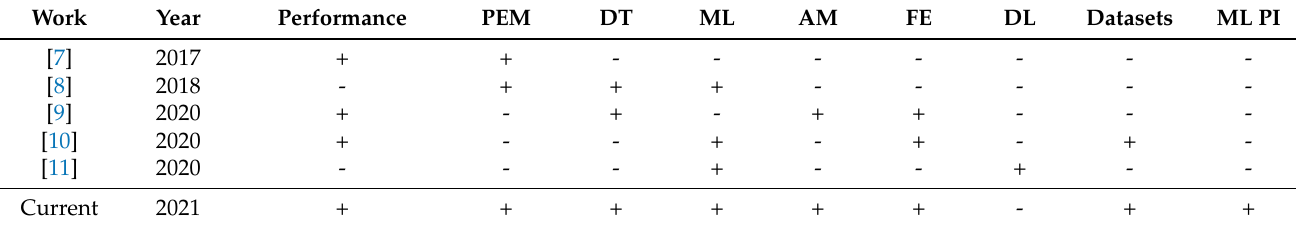
Table 2. Important topics addressed by the related works. PEM: performance evaluation metrics, DT: detection techniques, ML: machine learning, AM: analysis methods, FE: features and feature extraction, DL: deep learning, ML PI: ML performance